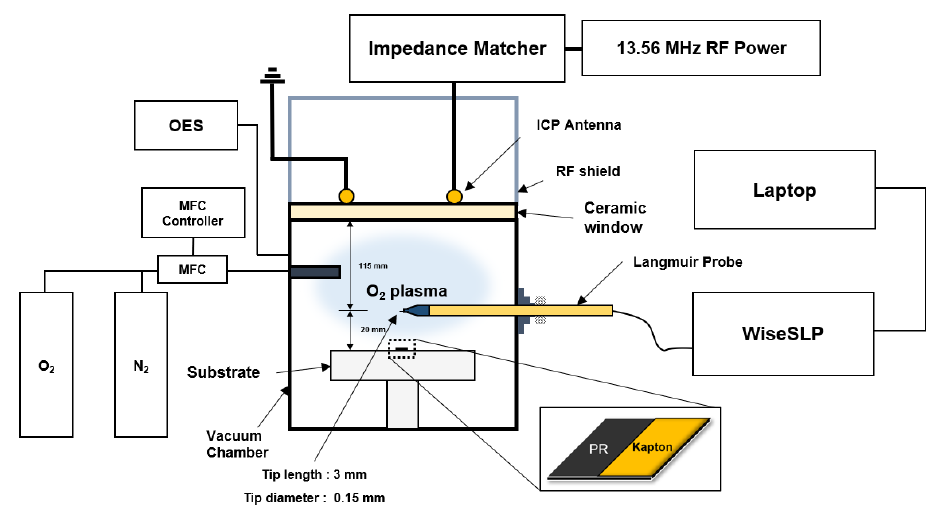
Figure 1. This is a schematic of experimental set-up, the ICPs reactor, and sample.